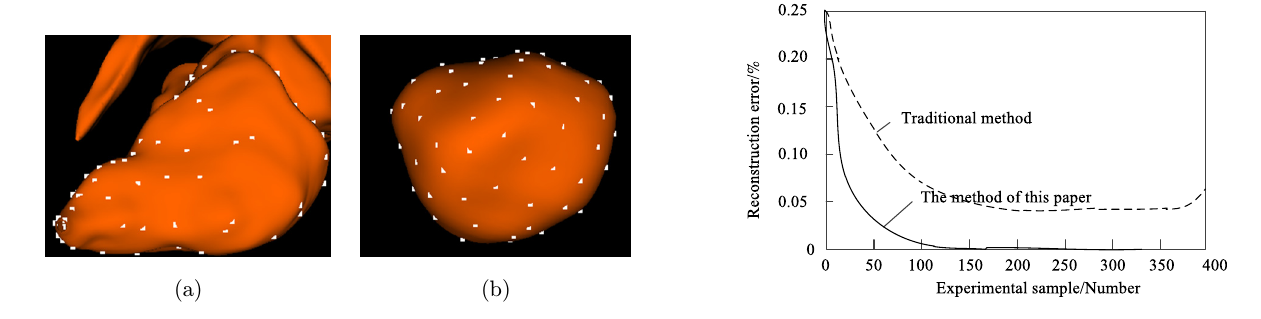
Fig. 5. Information enhancement of three-dimensional spiral CT damage image.